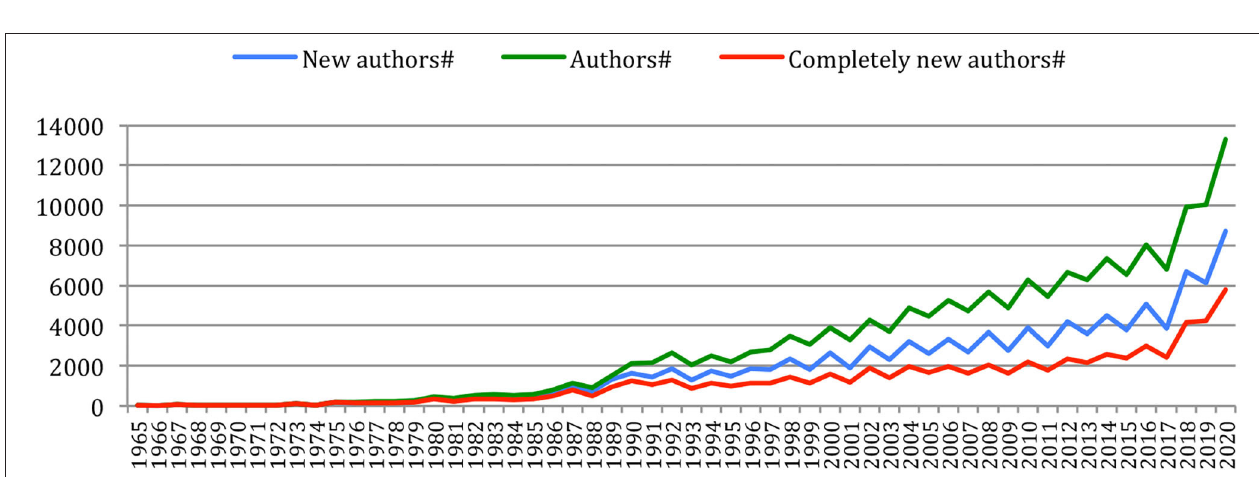
FIGURE 5 | Number of different authors, new authors, and completely new authors over